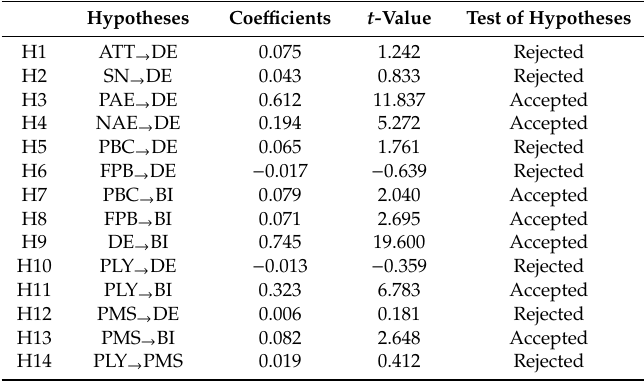
Table 4. Standardized parameter estimates of structural